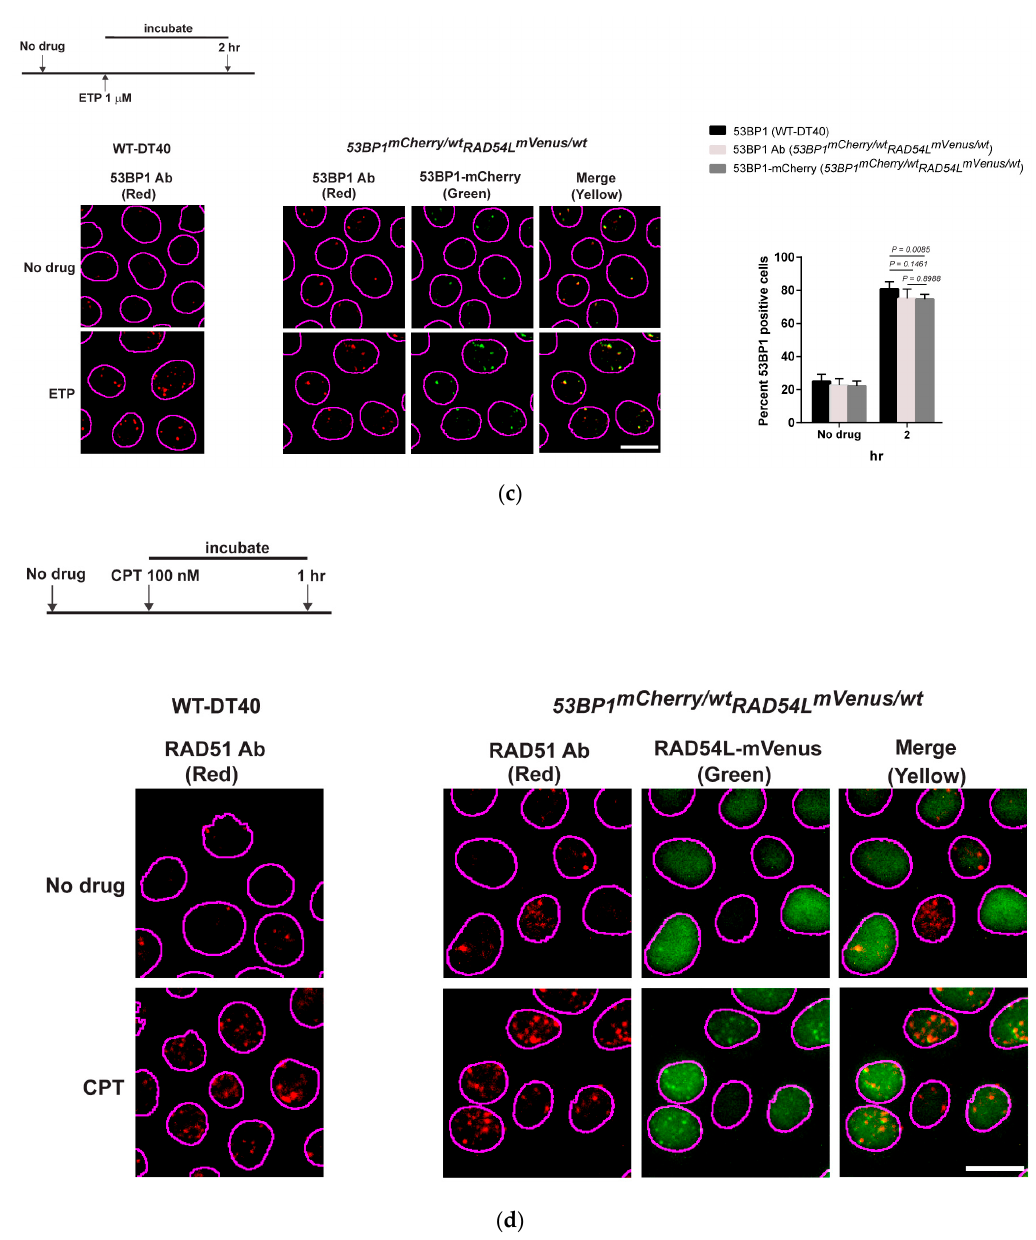
Figure 4. Foci formation of biosensor clones revealed the same phenotype as that of wild-type DT40. ( a ) γ H2AX (red dot) focus formation of wild-type and biosensor cells when treated with either CPT or ETP. ( b ) Colocalization (yellow) of γ H2AX (red) and 53BP1-mCherry (green) in wild-type and biosensor cells when treated with either CPT or ETP. ( c ) Colocalization (yellow) of 53BP1 antibody (red) and 53BP1-mCherry (green) in wild-type and biosensor cells when treated with ETP. ( d ) Colocalization (yellow) of the RAD51 antibody (red) and 53BP1-mCherry (green) in wild-type and biosensor cells when treated with CPT. The bar graphs are shown as the mean ± standard deviation. Definitions: 53BP1-mCherry-RAD54L-mVenus, tumor protein p53 binding protein-monomeric Cherry-RAD54-like-monomeric Venus knockin cells; WT, wild type, ETP, etoposide; CPT, camptothecin; Ab, antibody. Scale bar represents 10 µM.